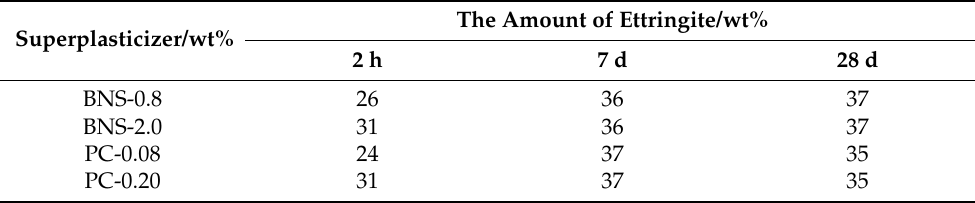
Table 6. The amount of ettringite in CSA pastes hydrated with different dosages of superplasticizer.